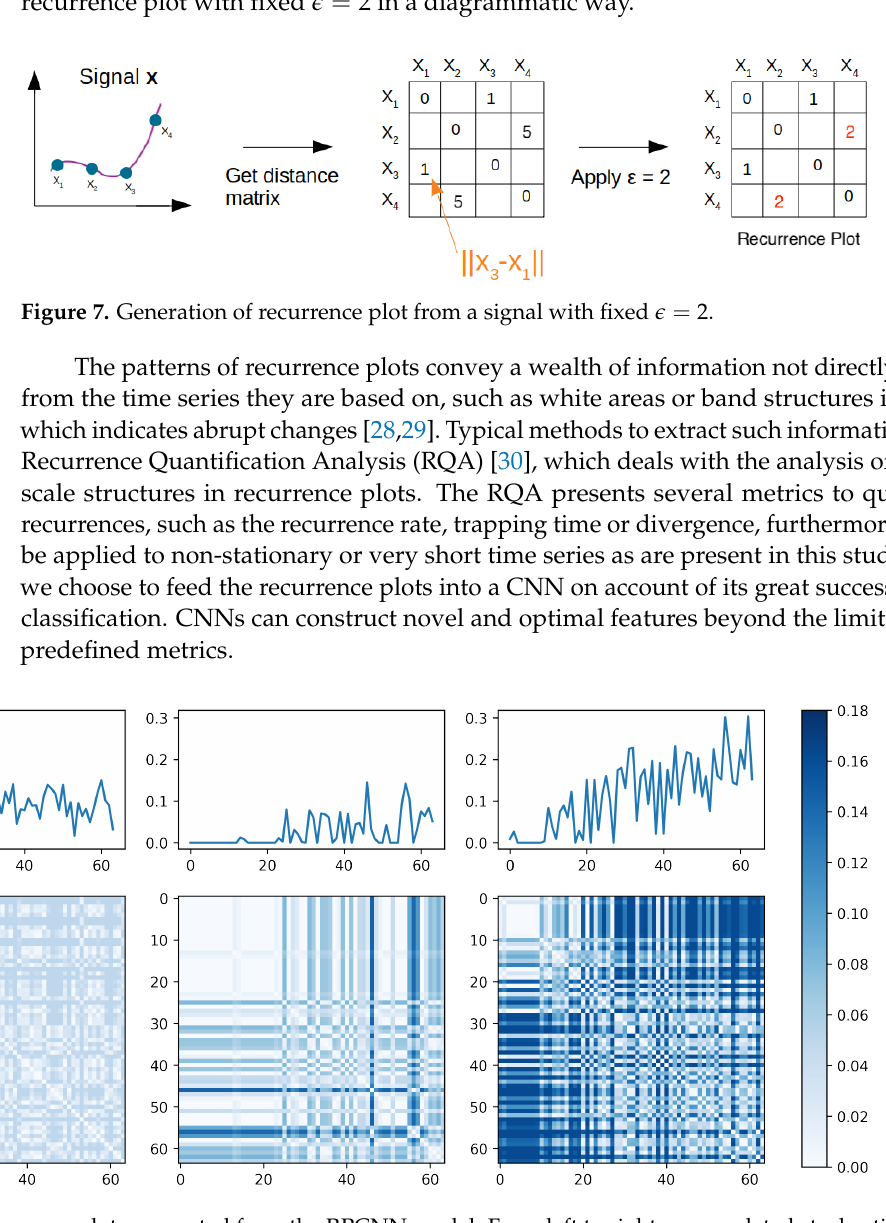
Figure 8. Examples of recurrence plots generated from the RPCNN model. From left to right: uncorrelated stochastic data, data starting to grow, and stochastic data with a linear trend. The top row shows the signals before the recurrence plot generation, and the bottom row shows the corresponding recurrence